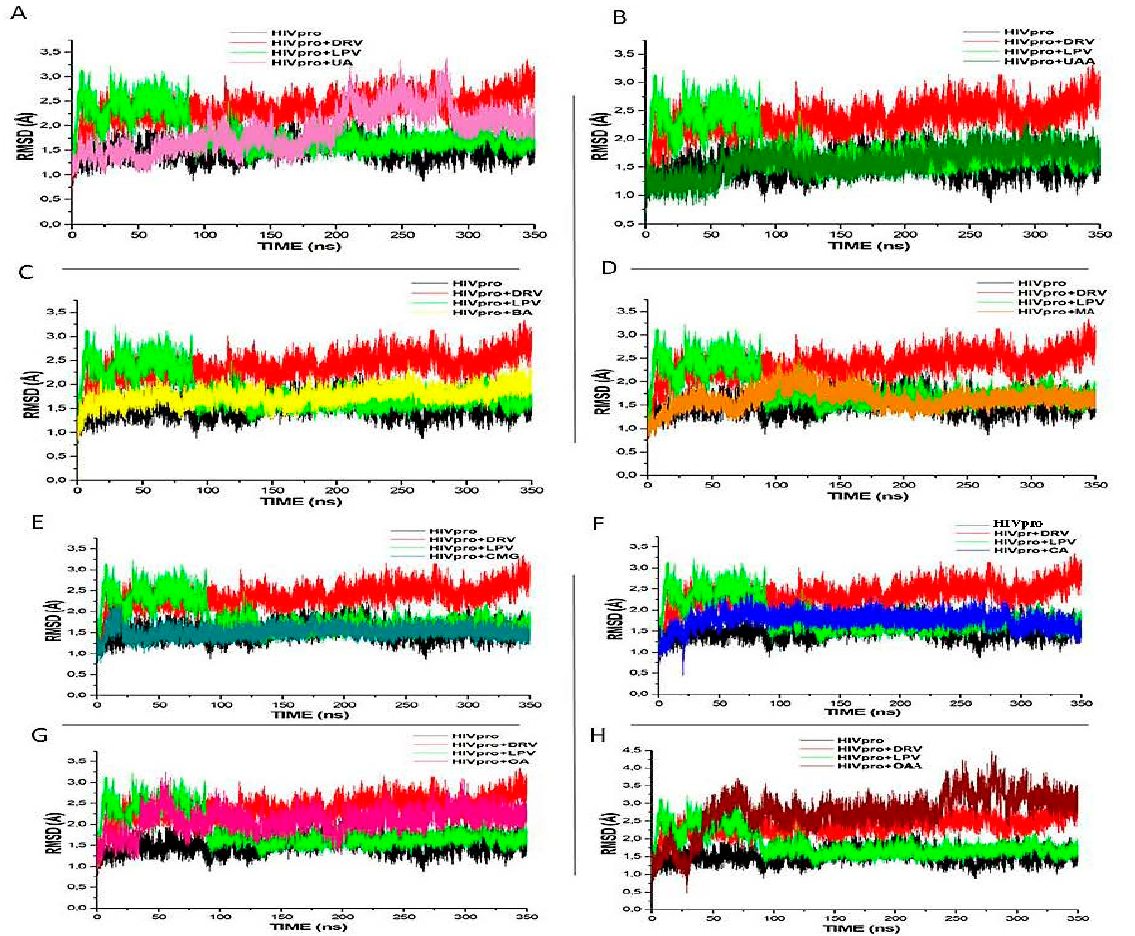
Figure 2. Comparative RMSD profiles of alpha-C atoms of the HIVpro with LPV, DRV, and ( A ) UA, ( B ) UAA, ( C ) BA, ( D ) MA, ( E ) CMG, ( F ) CA, ( G ) OA, and ( H ) OAA systems over a 350 ns molecular dynamics simulation.